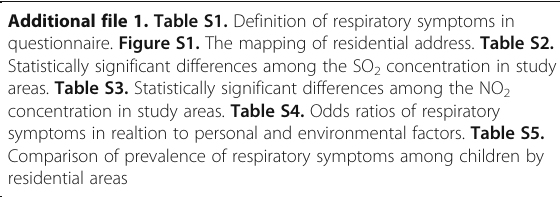
Additional file 1. Table S1. Definition of respiratory symptoms in questionnaire. Figure S1. The mapping of residential address. Table S2. Statistically significant differences among the SO 2 concentration in study areas. Table S3. Statistically significant differences among the NO 2 concentration in study areas. Table S4. Odds ratios of respiratory symptoms in realtion to personal and environmental factors. Table